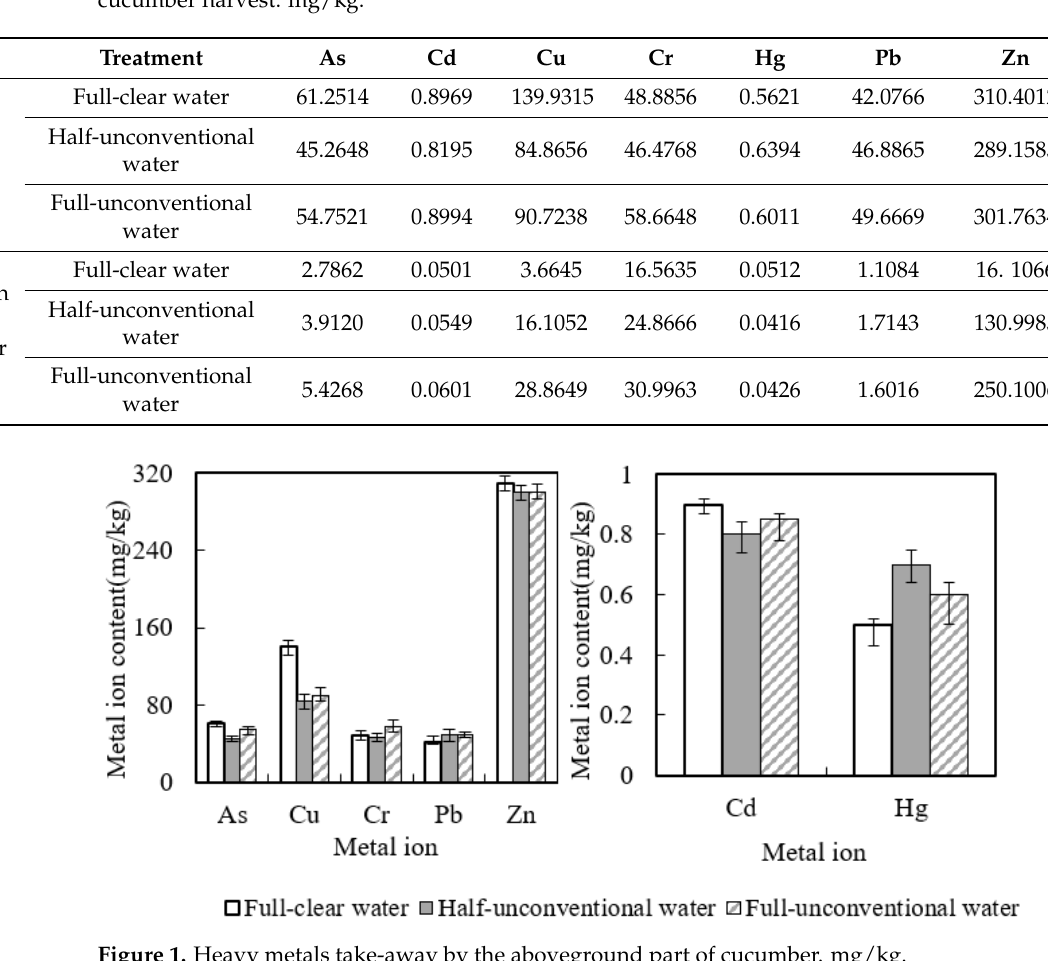
Figure 1. Heavy metals take-away by the aboveground part of cucumber. mg/kg.